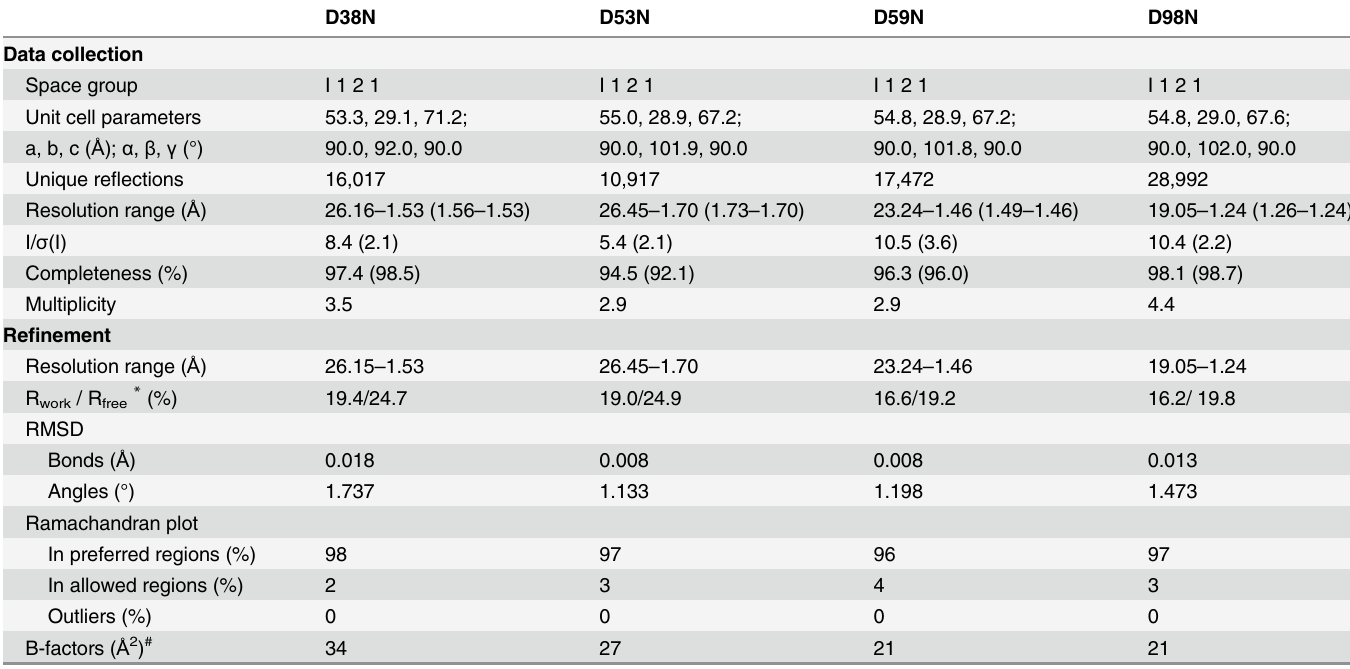
Table 2. Data collection and refinement statistics.